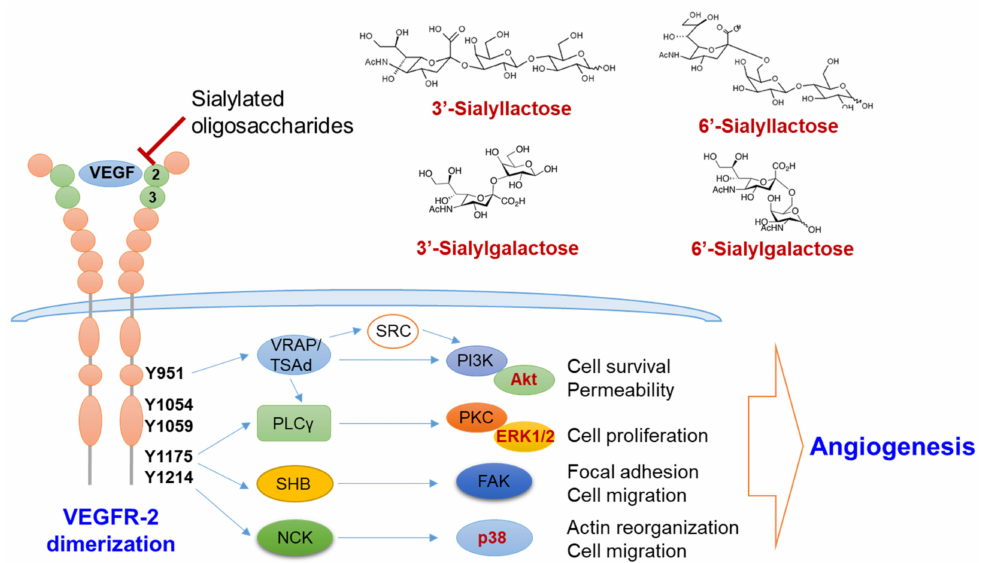
Figure 5. Molecular mechanism of the anti-angiogenic action by sialic acid-containing oligosaccharides. Sialylated lactose and sialylgalactose with sialic acid linked α 2-3 or α 2-6 to galactose inhibit the activation of VEGFR-2 by interfering the binding between VEGF and VEGFR-2 via Ig-like domain 2 and 3 (green circle). Inhibition of VEGFR-2 activation thereby suppresses the downstream angiogenic signaling pathways, such as the PI3K/Akt, PKC/ERK1/2 and p38 pathways. ERK1/2, extracellular signaling-regulated kinases 1/2; FAK, focal adhesion kinase; NCK, non-catalytic region of tyrosine kinase; PI3K, phosphoinositide 3-kinase; PLC γ , phospholipase γ ; PKC, protein kinase C; SHB, SH2 domain-containing adapter protein B; TSAd, T-cell specific adaptor protein; VEGF, vascular endothelial cell growth factor; VEGFR, vascular endothelial cell growth factor receptor; VRAP, VEGF-receptor activated